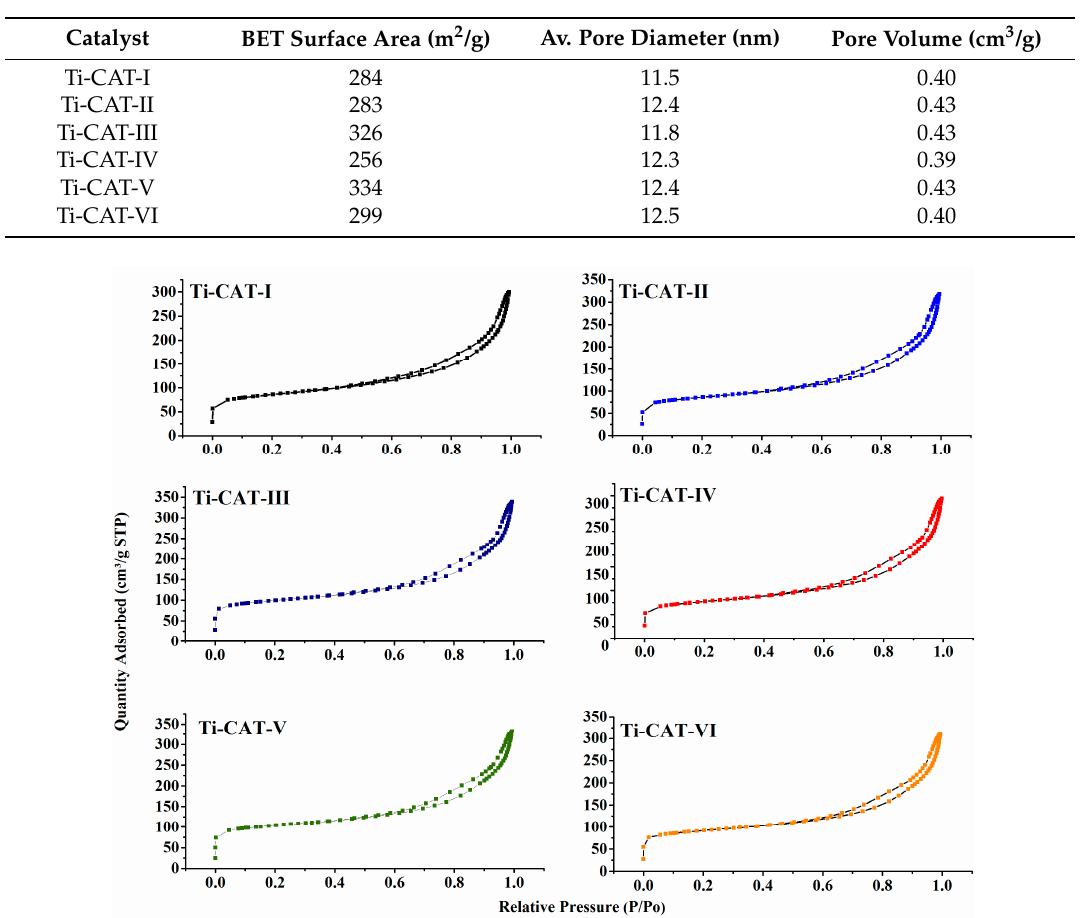
Table 2. N 2 physisorption results for the different catalysts.